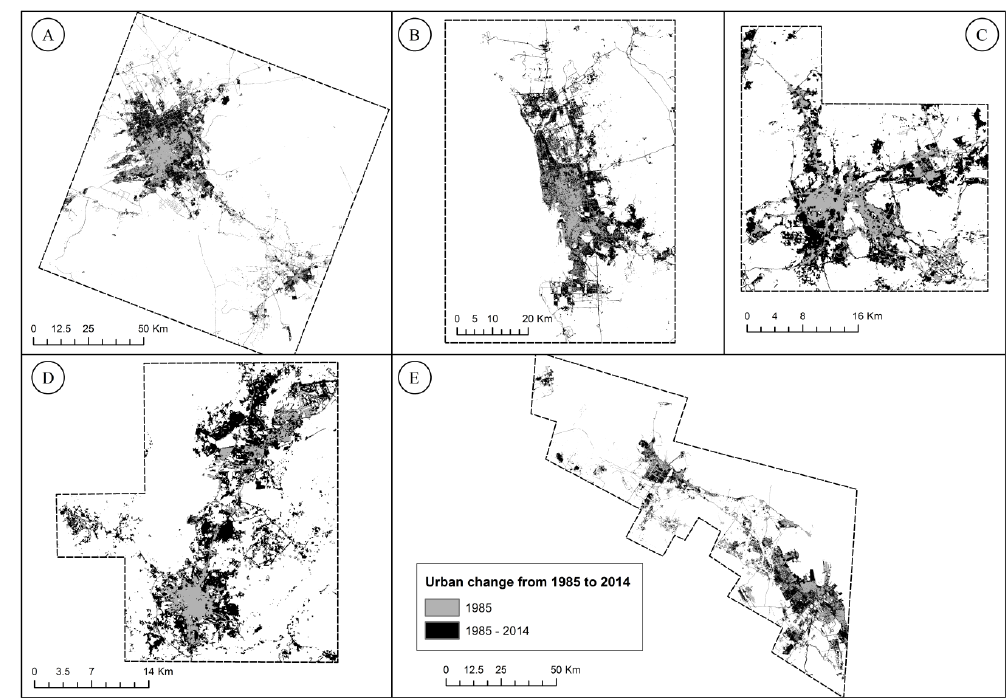
Figure 2. Urban areas in 1985 in grey and the expansion of urban areas from 1985 to 2014 in black in ( A ) Riyadh, ( B ) Jeddah, ( C ) Makkah, ( D ) Al-Taif and ( E ) Eastern Area